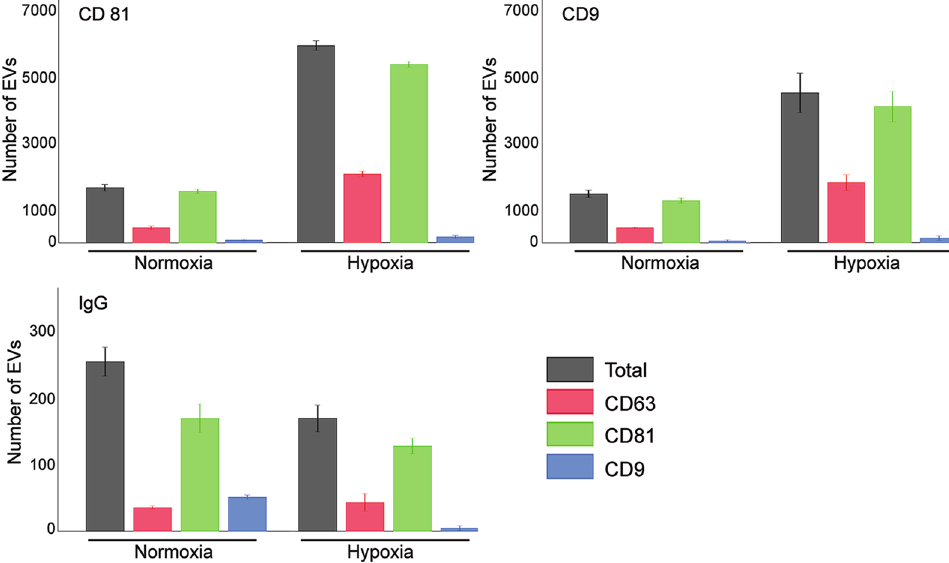
Figure 1. Characterization of EVs produced by Renca cells cultured under normoxia or hypoxia by ExoView. Names of the capture chips are shown in the upper left corners, total number of detected EVs in a sample (1 µg total protein) are shown by grey bars, number of EVs expressing CD63, CD81, and CD9 depicted by red, green, and blue bars,